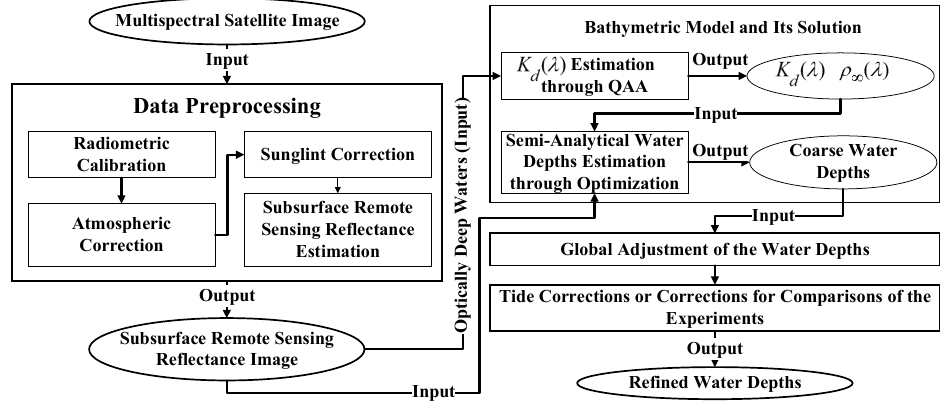
Figure 4. The flowchart of the implementation of the proposed bathymetric method.